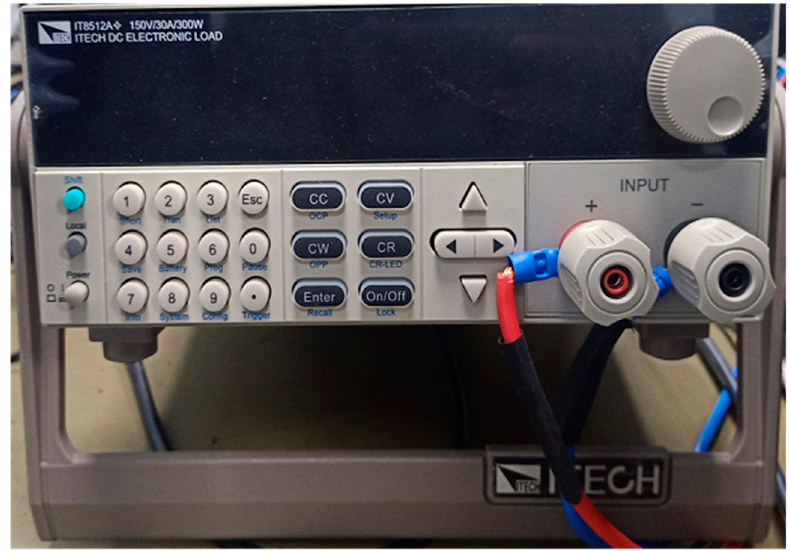
Figure 8. Programmable electronic load IT8512A+.